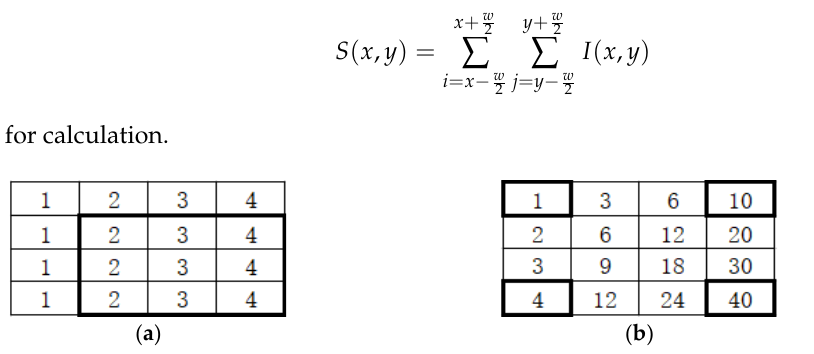
Figure 13a, you need to use